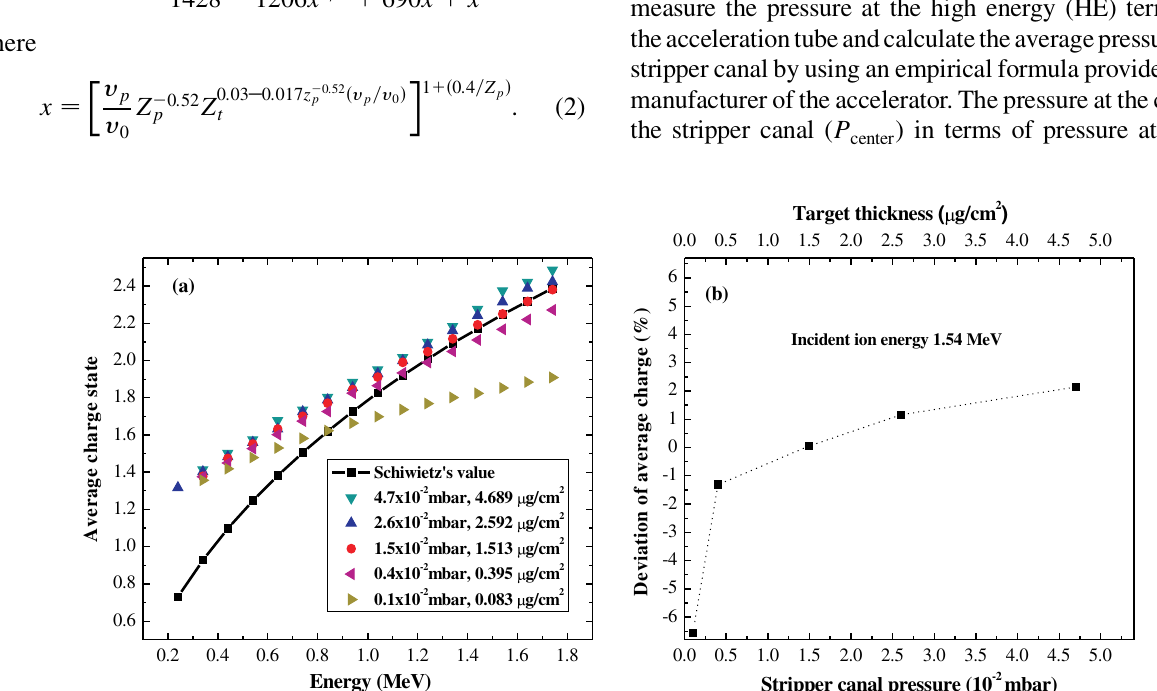
FIG. 2. (a) Variation of average charge of the outgoing beam with incident ion energy measured at different stripper gas pressures. gas, taking into account the average pressure in the stripper canal and its length. The The target thicknesses were calculated for N 2 connected data points represent the empirical values of equilibrium average charge predicted by Schiwietz’s formula [11]. (b) Variation of deviation of experimental average charge ð q exp avg (cid:1) q emp avg Þ =Z p with stripper gas pressure, at 1.54 MeV of incident ion